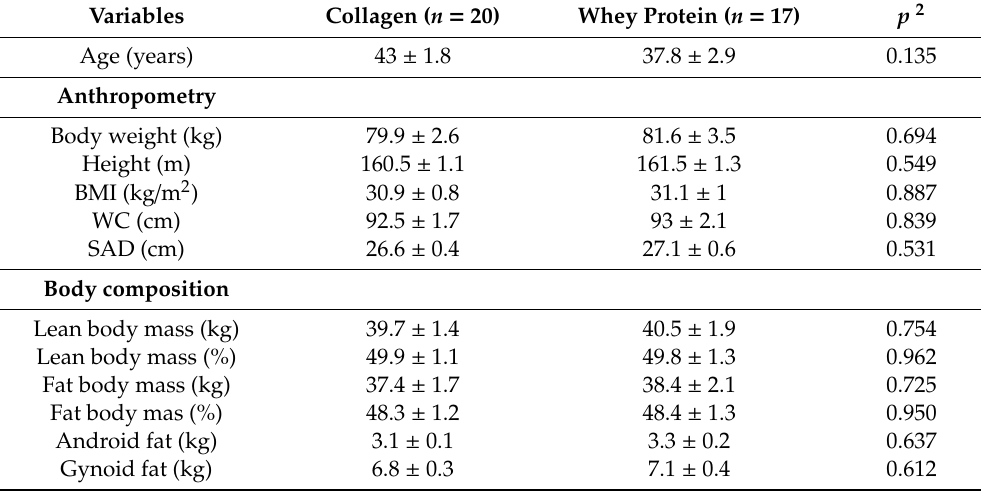
Figure 1. CONSORT flow diagram. CONSORT, Consolidated Standards of Reporting Trials. CG: collagen group, WG: whey protein group. Table 1. Baseline characteristics 1